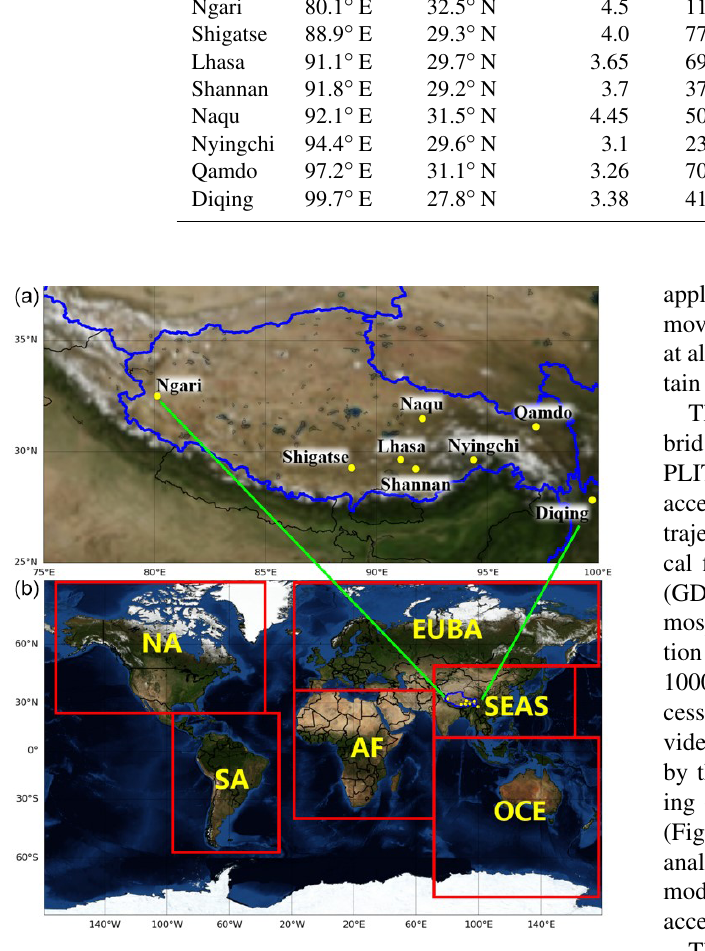
Figure 1. Enlarged view for geolocations of all cities (yellow dots) over the Himalayas and Tibetan Plateau (HTP) (a) . Geographical regions implemented in the standard GEOS-Chem tagged CO sim- ulation (b) . Latitude and longitude definitions are listed in Table 2. The base map is created by the Basemap package of